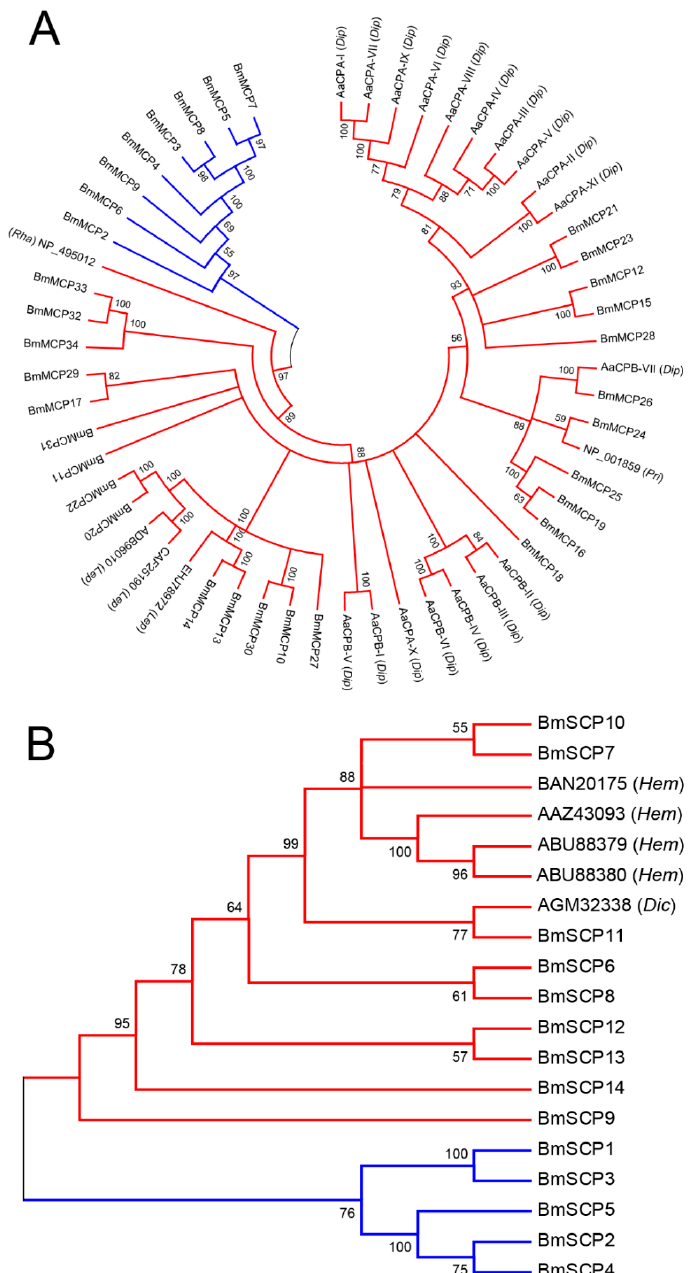
Figure 1. Phylogenetic analysis of carboxypeptidase amino acids. ( A ) Neighbor-joining tree of the metal carboxypeptidase family. Red lines represent metal carboxypeptidases with the Peptidase_M14 domain, and blue lines represent metal carboxypeptidases with the Peptidase_M2 domain; ( B ) Neighbor-joining tree for the serine carboxypeptidase family. Red lines represent serine carboxypeptidases with the Peptidase_S10 domain, and blue lines represent serine carboxypeptidases with the Peptidase_S28 domain. The number at each branch represents the percentage of 1000 bootstrap iterations. Values below 50% were omitted. Abbreviations: Rha , Rhabditida ; Pri , Primates ; Lep , Lepidoptera ; Dip , Diptera ; Hem , Hemiptera ; Dic , Dictyoptera .